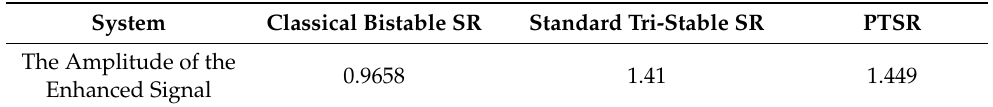
Table 1. Signal enhancement contrast. System Classical Bistable SR Standard Tri-Stable SR PTSR The Amplitude of the 0.9658 1.41 Enhanced Signal